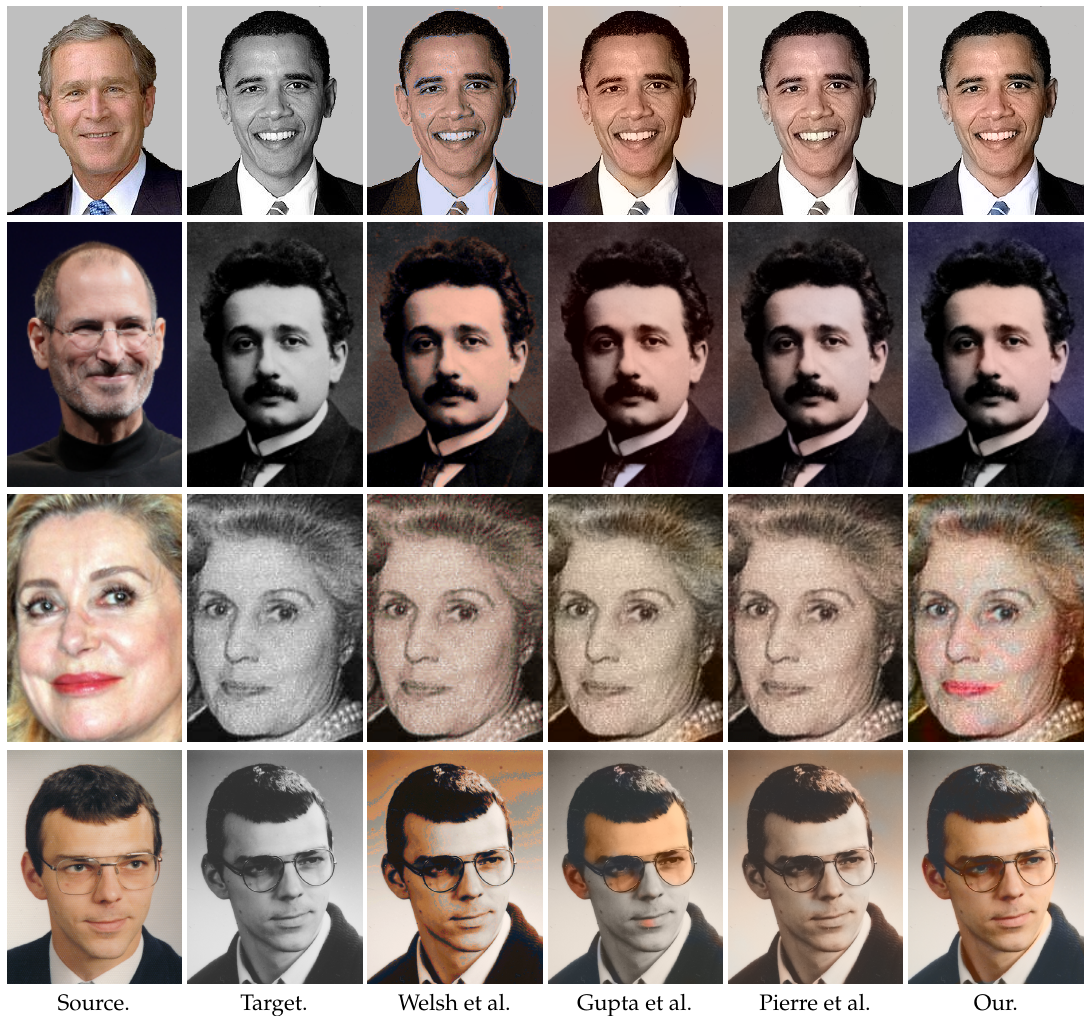
Figure 5. Comparison of our approach with state-of-the-art methods on photographies. In contrast to these methods our model is not based on texture comparisons, but on the morphing of the shapes. Therefore it is able to handle faces images, where the background has frequently a similar texture as the